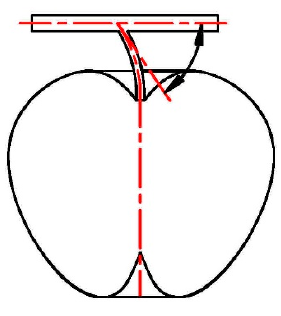
Figure 18. The natural growth angle of apple.